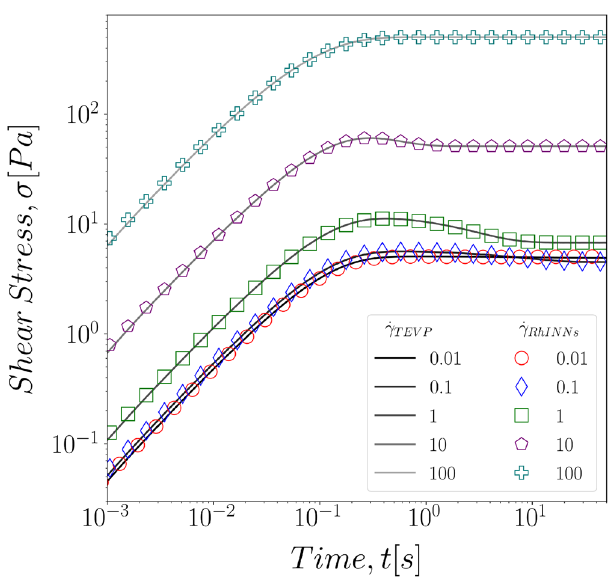
Figure 4. Direct RhINNs solution of a TEVP fluid under constant shear rate flow start-up protocol, with deformation rates ranging from ˙ γ = 0.01 − 100 s − 1 . The TEVP model parameters are: G = 70 [ Pa ] , σ y = 5 [ Pa ]